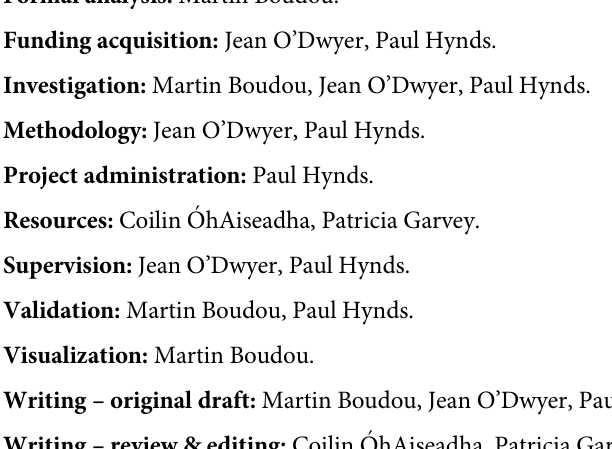
S1 Table. Pobal HP deprivation index components and descriptions. S2 Table. Pobal HP Index absolute and relative deprivation index score